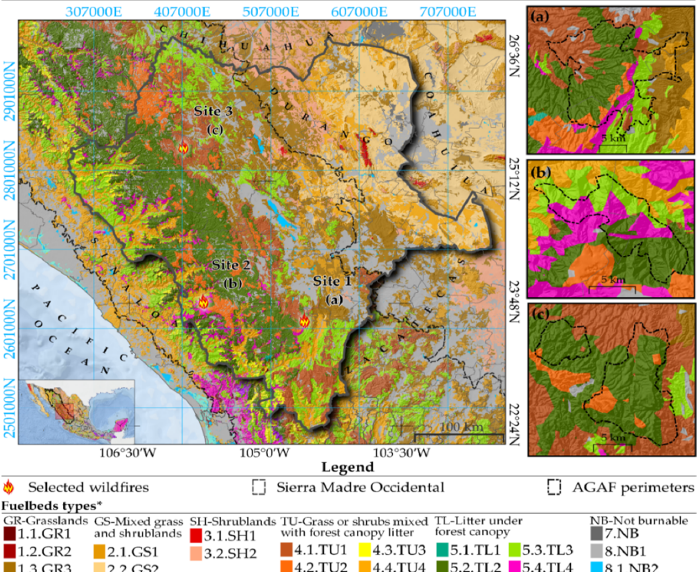
Figure 1. Location of the three 2019 wildfires analyzed in Durango State, Mexico, where ( a ) = Site 1, ( b ) = Site 2, ( c ) = Site 3, AGAF = aggregated active fire perimeter [75], fuelbed types (scale: